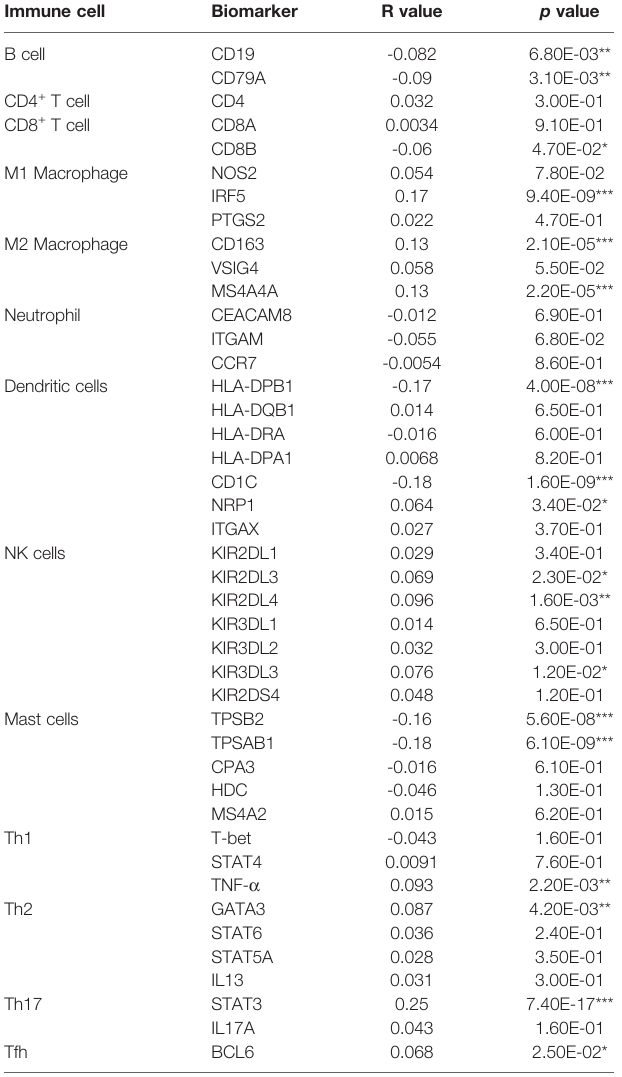
TABLE 2 | Correlation analysis between EMC2 and biomarkers of immune cells in BRCA determined by GEPIA2 database. Immune cell